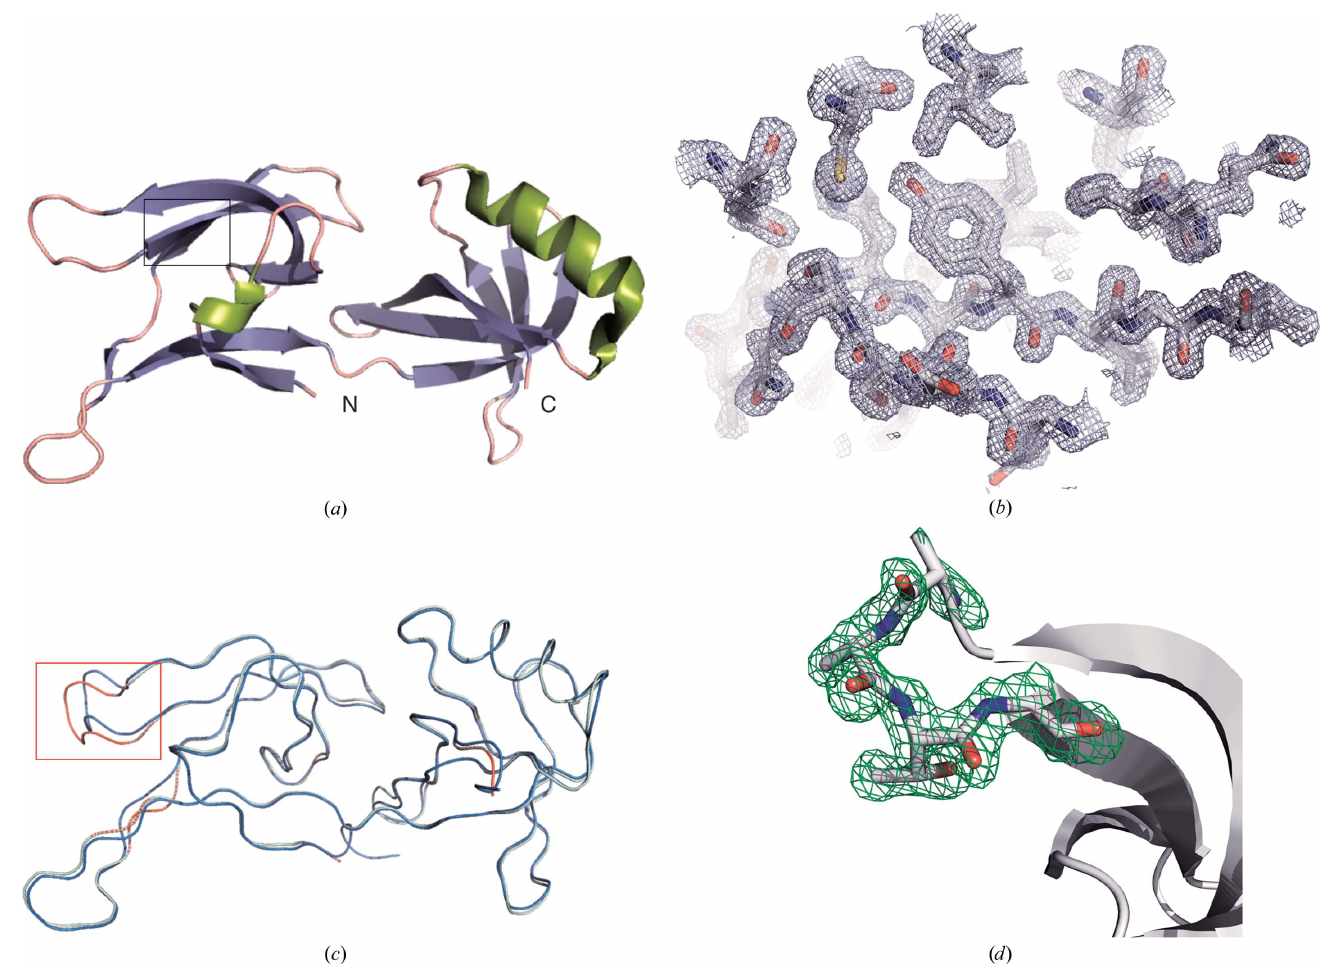
Figure 4 Details of the HEX-1 structure. ( a ) Overall structure of HEX-1 in cartoon representation. ( b ) Representative region of the electron-density map of HEX-1 obtained by FT-SFX of intracellular crystals at 1.8 A˚ resolution from a single chip (PDB entry 7asx). The detailed region is marked by a black box in ( a ). ( c ) Structural homology of HEX-1 crystallized in insect cells and HEX-1 purified from E. coli and crystallized by sitting-drop vapour diffusion. A backbone representation of the HEX-1 structure (green) obtained from in cellulo diffraction is superimposed with that of the HEX-1 reference structure (PDB code 1khi; blue). The average r.m.s.d. is 0.47 A˚ for equivalent C (cid:2) atoms. The only region showing major structural differences with r.m.s.d.s above 0.6 A˚ is highlighted by the red box. ( d ) OMIT map of residues 62–65 of the FT-SFX HEX-1 structure with the same residues in stick representation. The F o (cid:6) F c map (green) of the region of largest r.m.s.d.s with the reference structure, highlighted in ( c ), is contoured at 3 (cid:5)